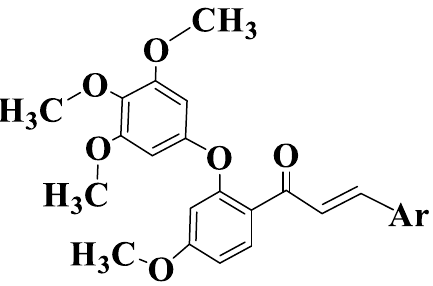
Figure 9. General structure of chalcones 162 – 177 .